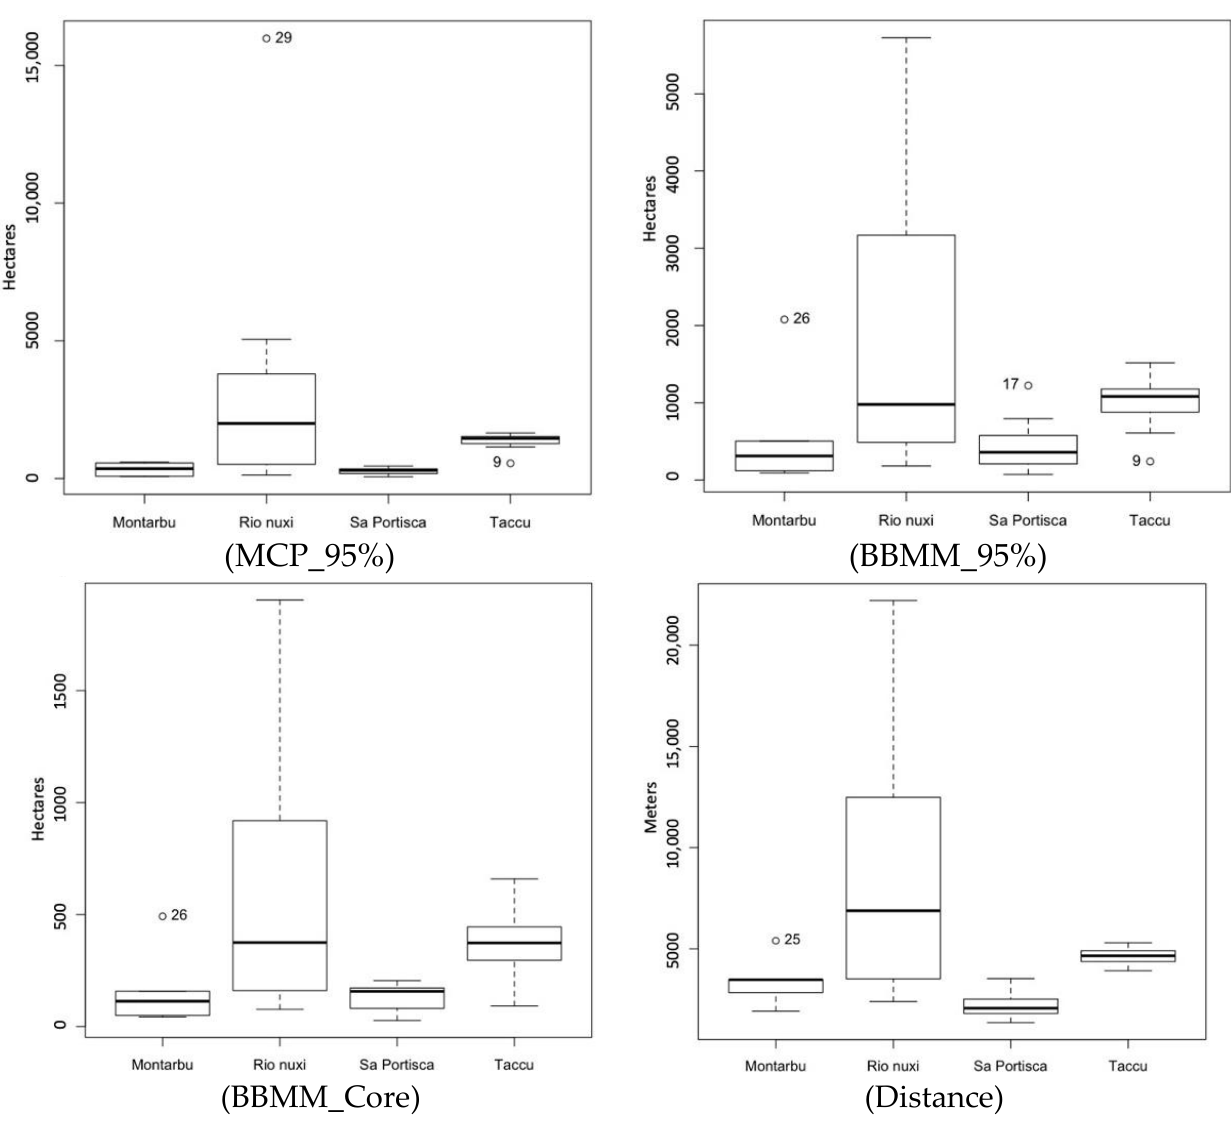
Figure 2. Box plots of home ranges and dispersal compared among reintroduction